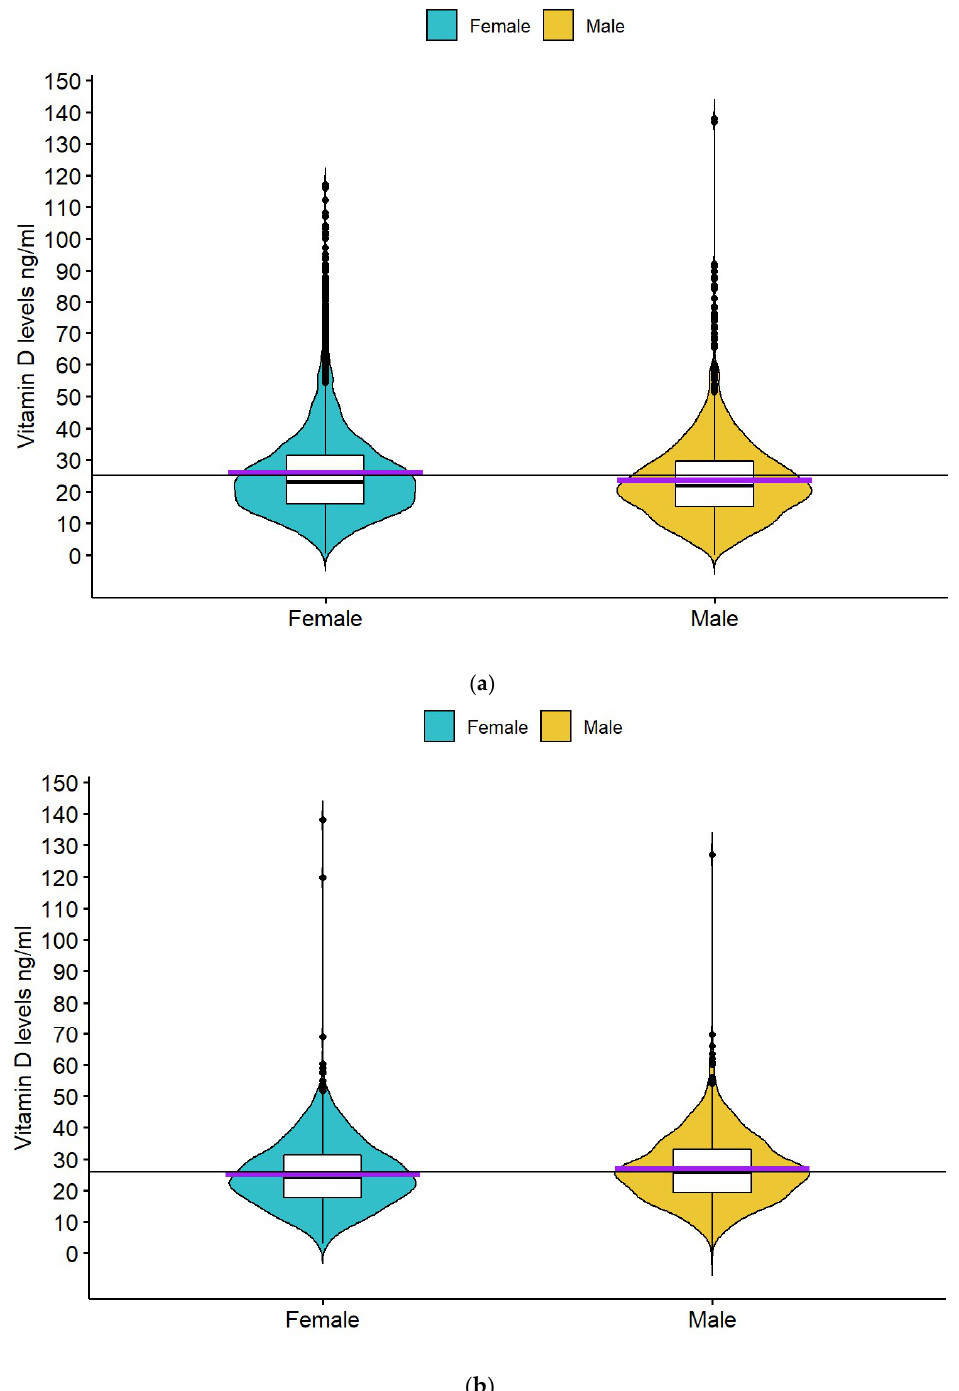
Figure 1. ( a ) Boxplot of 25 ( OH ) D levels according to gender for the Greek database. The short horizontal purple line is the mean, and the short black line represents the median of each group of subjects. The continuous horizontal black line represents the mean for the whole population sample. ( b ) Boxplot of 25 ( OH ) D levels according to gender for the Cypriot Database. The short horizontal purple line is the mean, and the short black horizontal line represents the median of each group of subjects. The continuous horizontal black line represents the mean for the whole population sample.